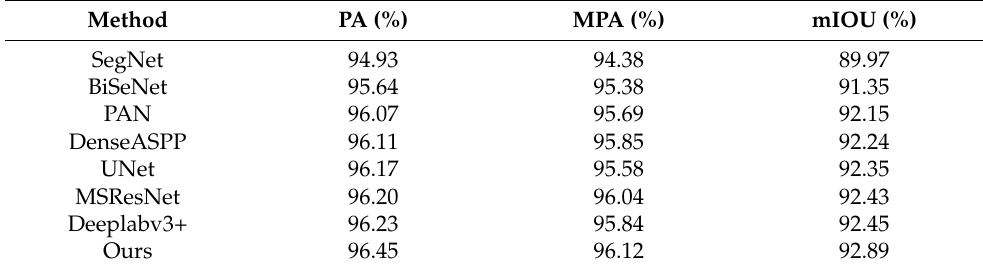
Table 5. Comparison of evaluation indexes of different models in LandCover dataset.